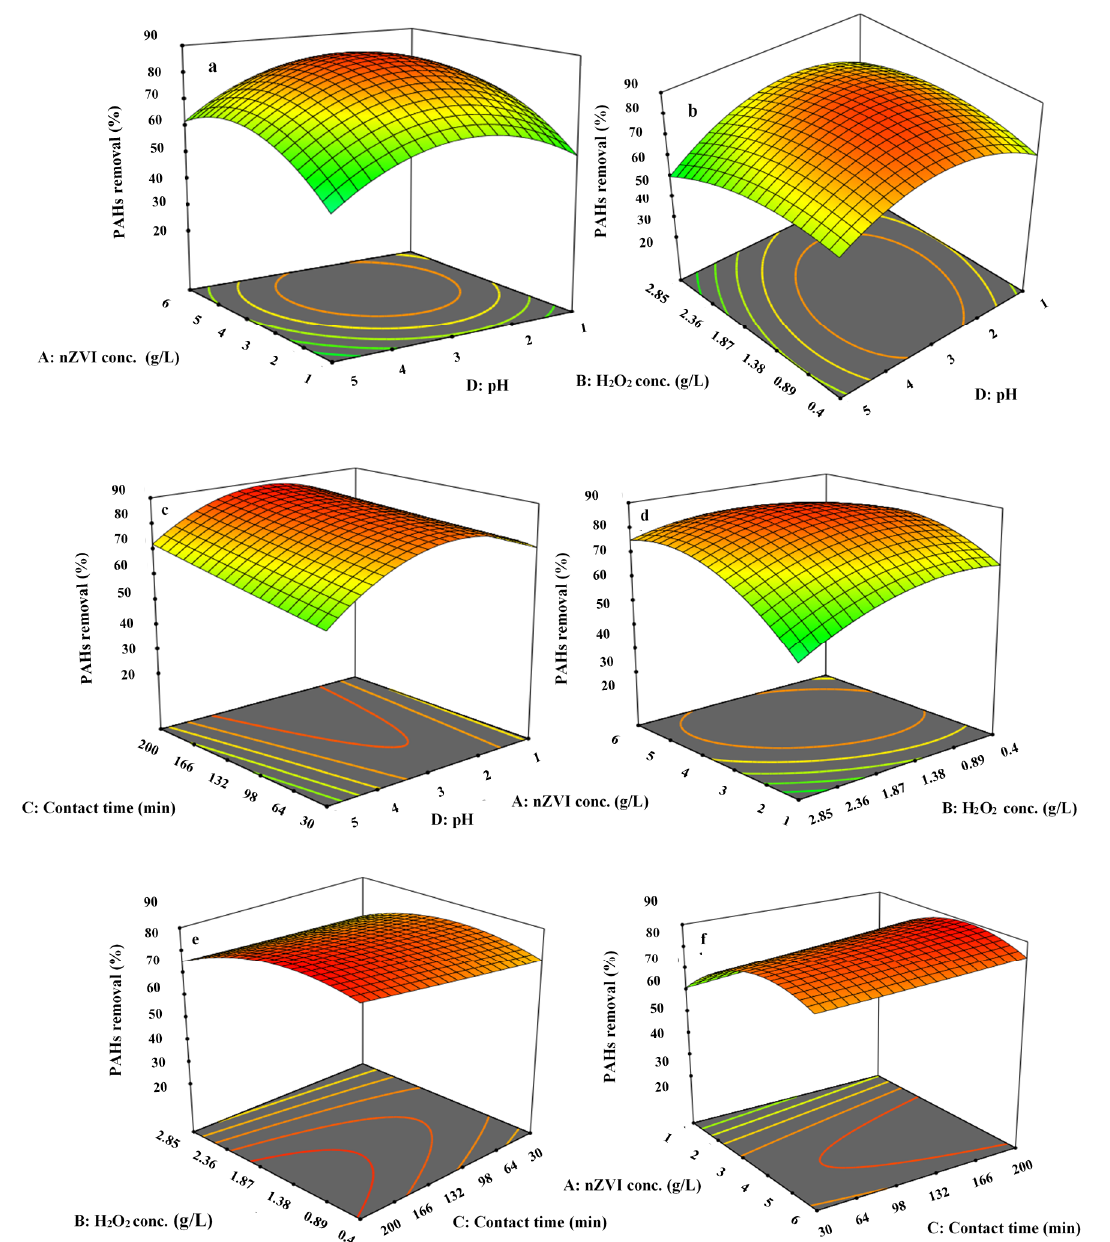
Figure 6. PAHs removal (%) 3D plot; ( a ) nZVI dosage vs. pH, ( b ) H 2 O 2 conc. vs. pH ( c ), contact time vs. pH, ( d ) nZVI dosage vs. H 2 O 2, ( e ) H 2 O 2 conc. vs. contact time, ( f ) nZVI vs. contact time.